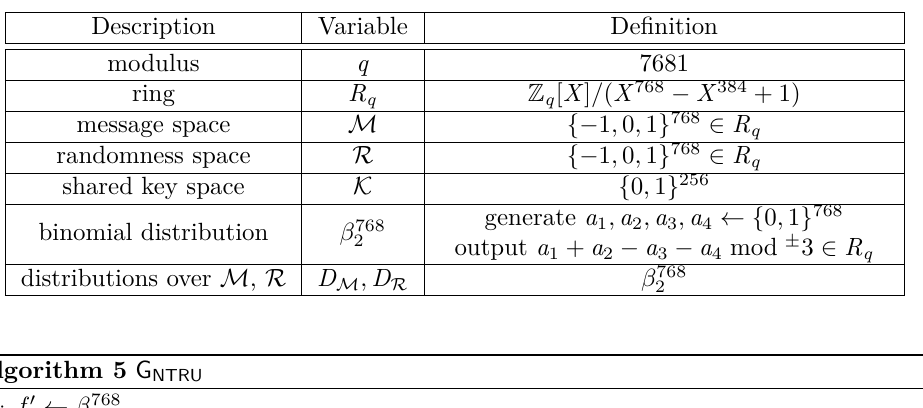
Table 4: NTRU Variable